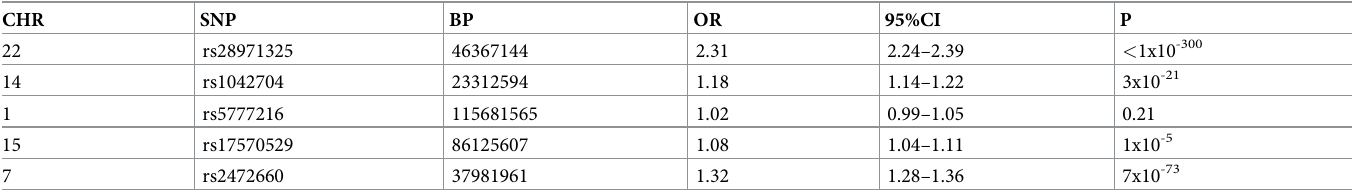
Table 3. Association of frozen shoulder genetic loci with Dupuytren’s Disease.